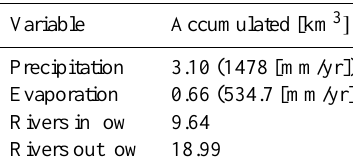
Table 3. Historic water balance for basin river Baker (1951 to 1980: Water Balance,